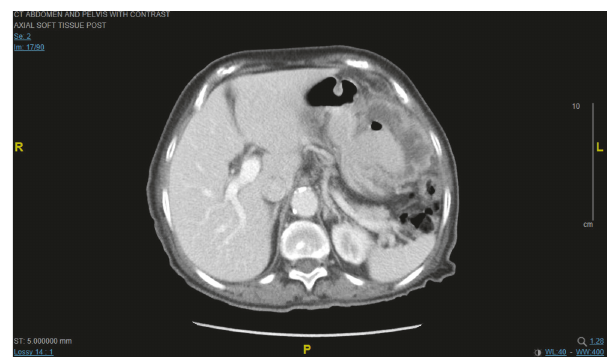
Figure 3: CT abdomen with IV contrast: axial